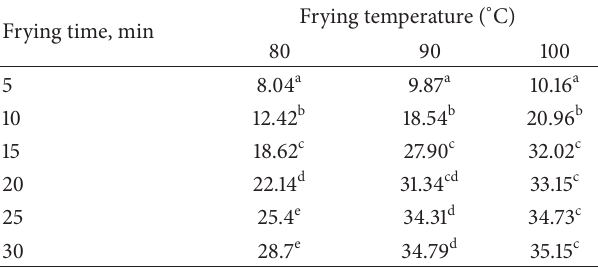
Values in same column with different superscripts differ significantly ( 𝑃 < 0.05